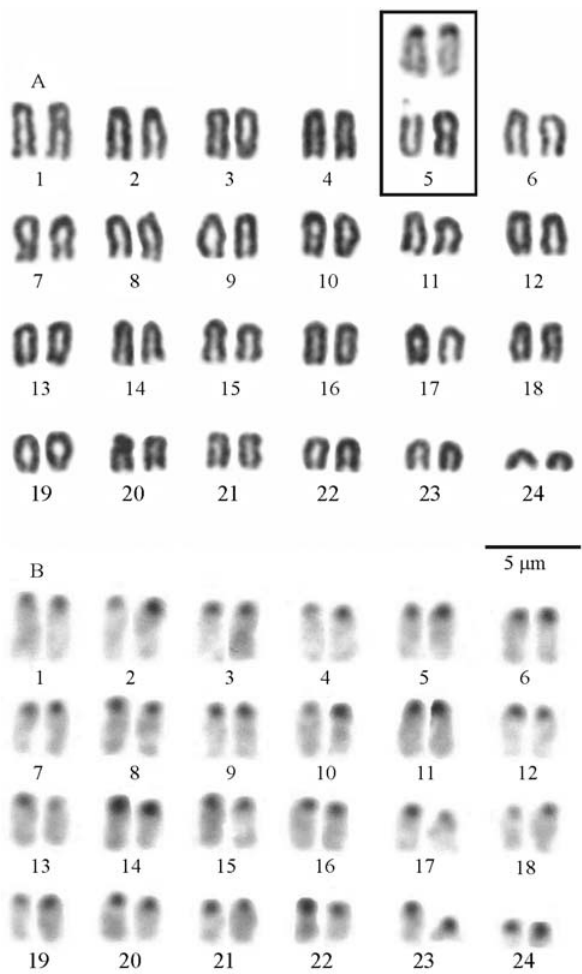
Figure 6 - Karyotype of Lutjanus analis . (A) Conventional Giemsa stain- ing. In detail, the secondary constrictions equivalent to NORs. (B) C-banding in Lutjanus analis .